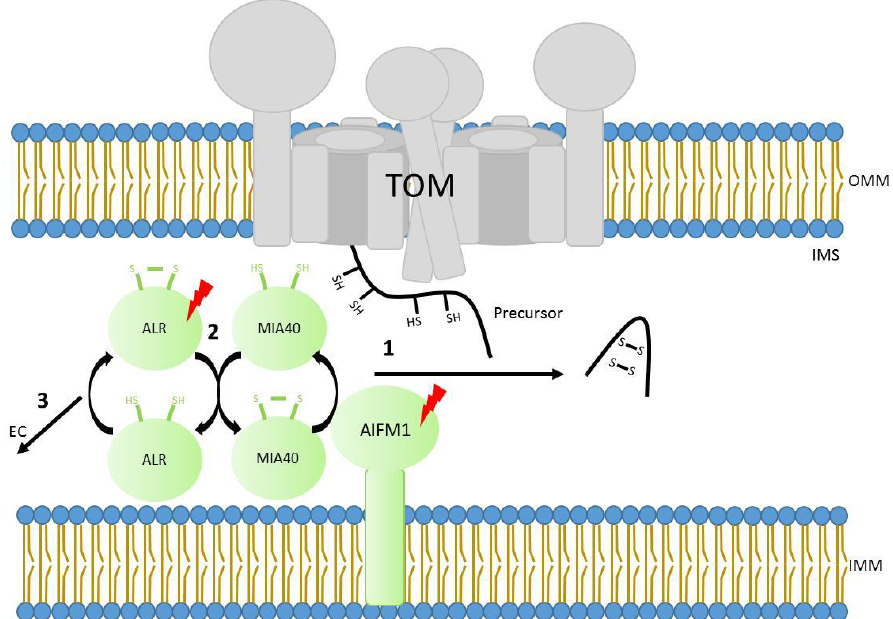
Figure 2. Scheme of translocation and stabilization of mitochondrial precursors residing in the IMS. 1. After crossing the outer membrane through the TOM complex, precursors containing specific cysteine motives are recognized by MIA40 and oxidized, trapping precursors in the IMS. AIFM1 regulates MIA40 mediated import 2. The cysteines in MIA40 are reduced during the trapping of precursors, being re-oxidized by ALR. 3. ALR also regenerates its oxidized cysteines by transferring the electrons to Cyt c and molecular oxygen in the electron transport chain (EC). Lightning Bolt: Subunits with known mutations associated with mitochondrial diseases. OMM, outer mitochondrial membrane. IMS, intermembrane space. IMM, inner mitochondrial